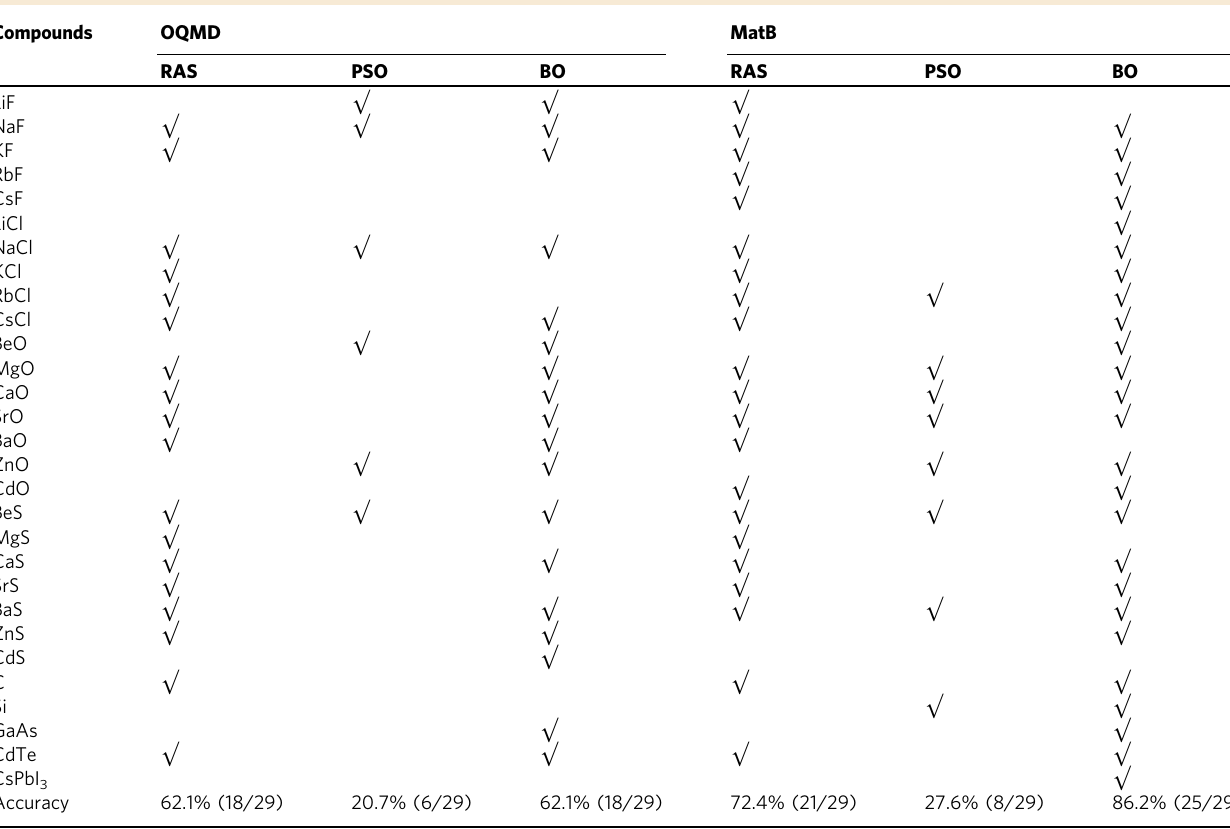
Table 1 The performance of GN-OA with different combinations of databases (OQMD and MatB) and optimization algorithms (RAS, PSO, BO) for crystal structure prediction of 29 typical